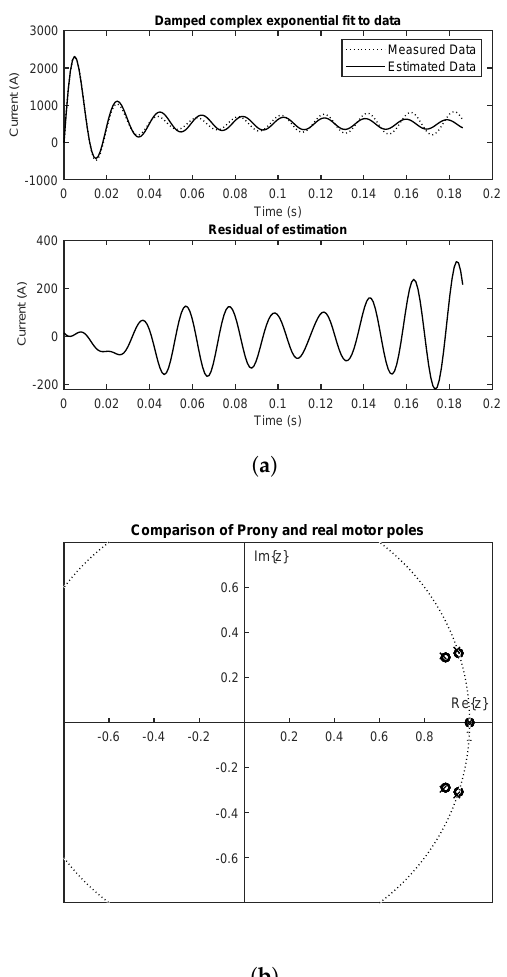
Figure 1. ( a ) Damped complex exponential fit to simulated data ( i d ) in the 1st interval, with Γ = ˆ Γ ; ( b ) Poles computed from optimal fitted model ( × ) and real motor poles